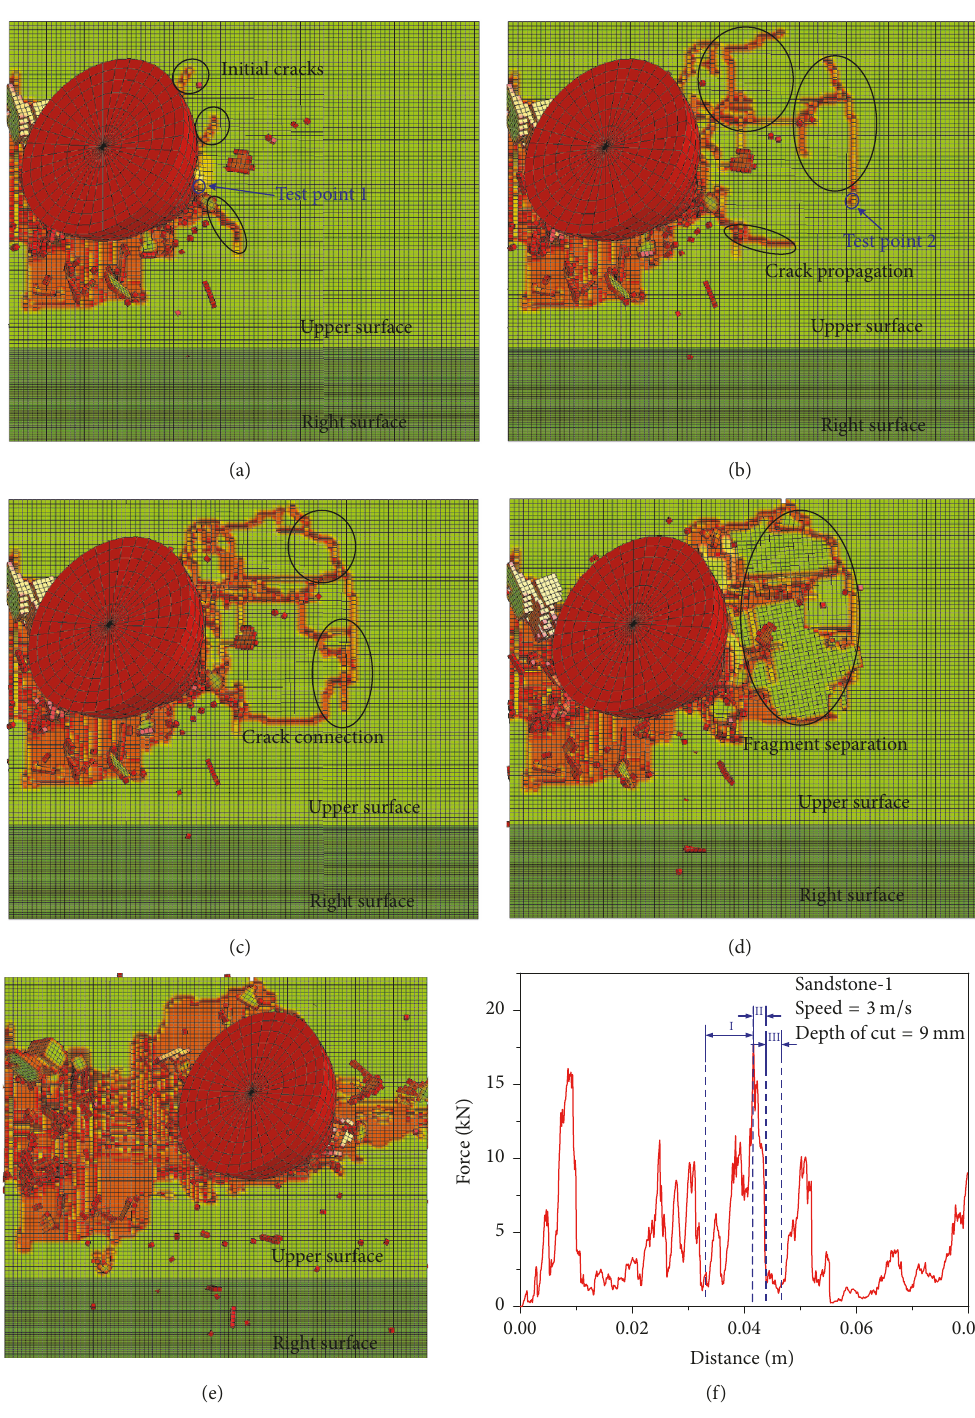
Figure 4: The cutting process of the rock for a cutting depth of 9mm, a cutter speed of 3 m/s, and sandstone-1: (a) initial crack generation at 0.01318 s, (b) crack propagation at 0.1344 s, (c) crack connection at 0.01370 s, (d) fragment separation from the base rock at 0.1472 s, (e) cutting result at 0.02667 s, and (f) variation in the cutting